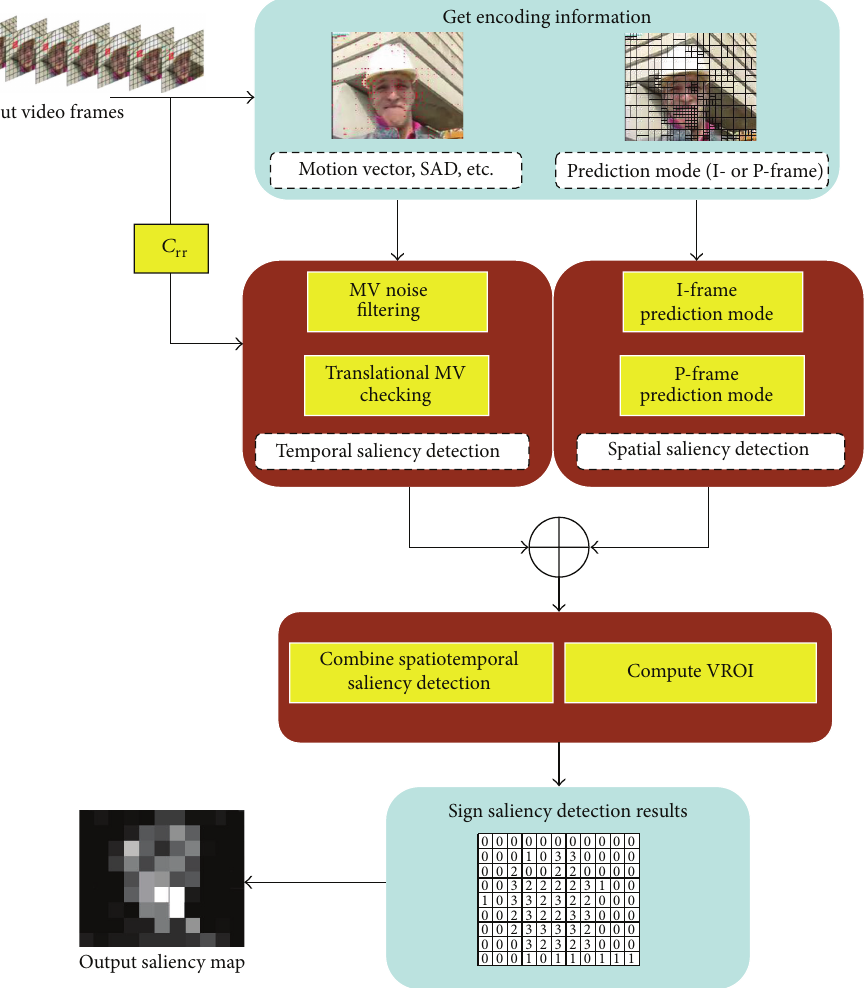
Figure 14: Diagram of proposed saliency detection algorithm